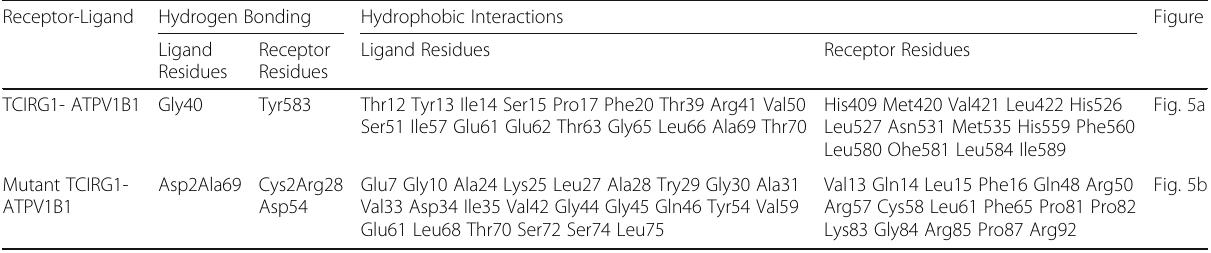
Table 1 Docking interactions: amino acid residues involved in hydrogen bonding and hydrophobic interactions Receptor-Ligand Hydrogen